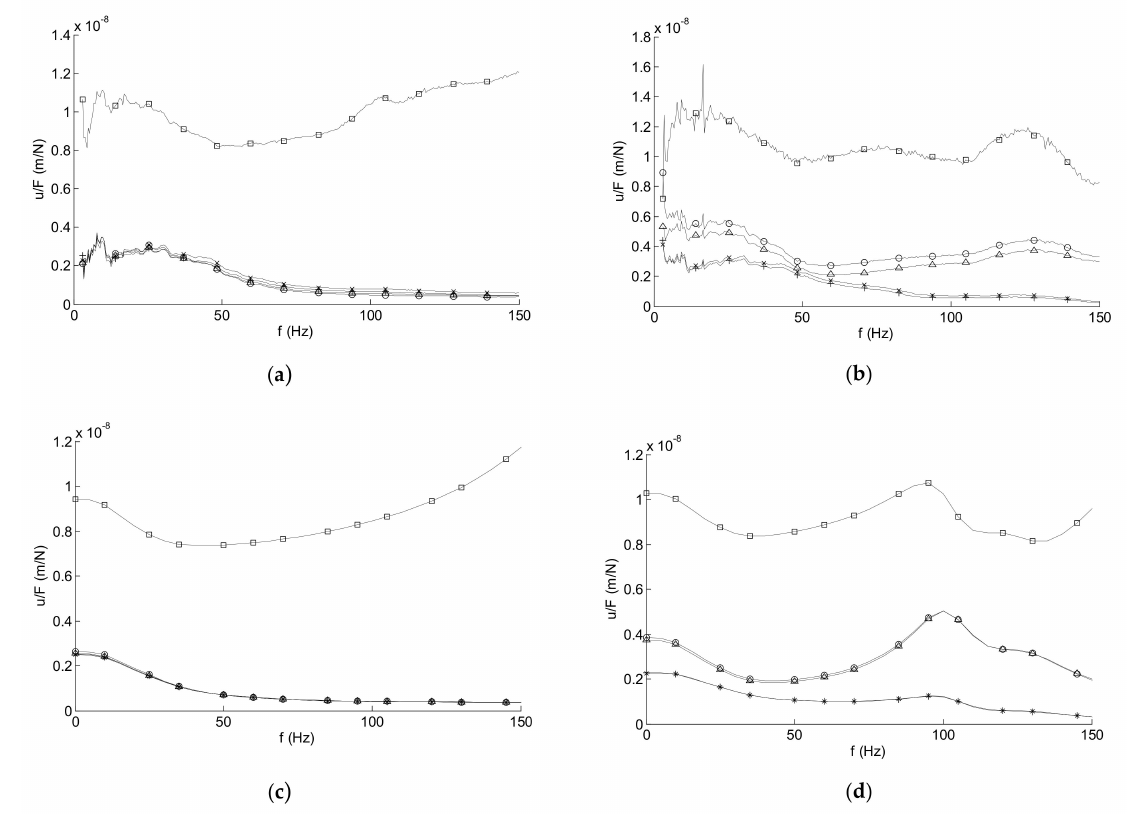
Figure 16. Receptance functions of slab tracks at Site W: measurement ( a , b ) and calculation (( c , d ) FEBEM results), rail, sleeper, (cid:52) track plate (cid:53) base plate, + base layer, intact (left), and damaged (cid:50) (cid:35) track (right).